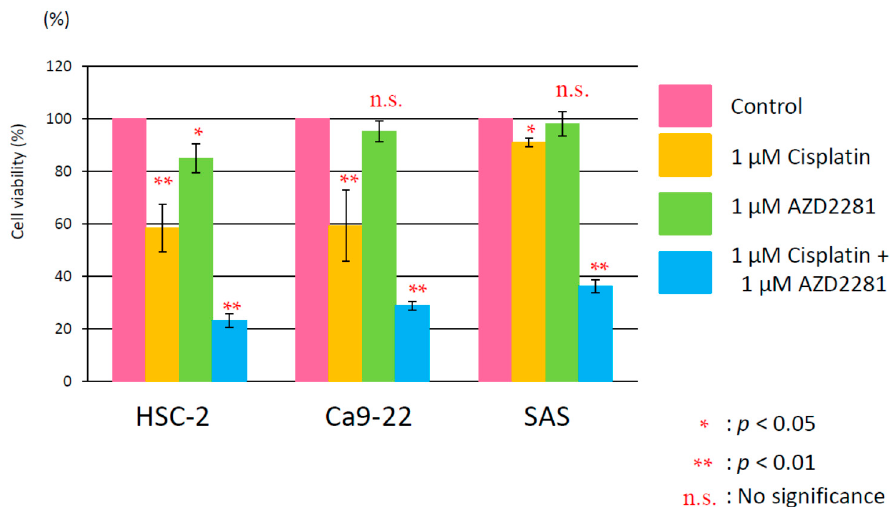
Figure 1. Attenuated relative cell growth by combinatorial treatment with 1 µM cisplatin and 1 µM AZD2281. Values are expressed as the mean ± SEM. * p < 0.05; ** p < 0.01; n.s., no significance. AZD2281. Values are expressed as the mean ˘ SEM. * p < 0.05; ** p < 0.01; n.s., no